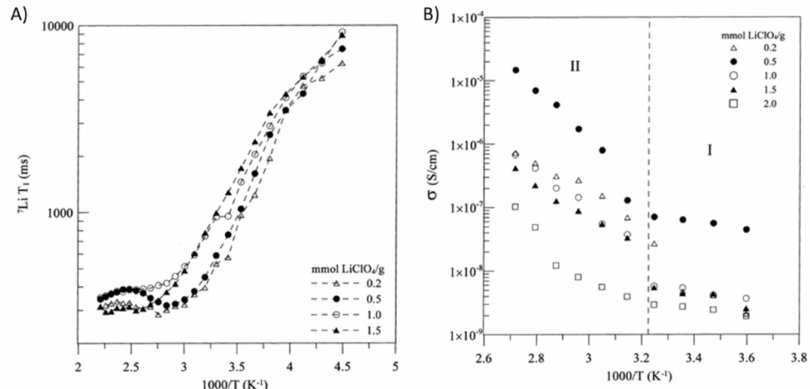
Figure 8. ( A ) Variable temperature T 1 relaxation times for a series of LiClO 4 -doped polyurethane- poly(dimethylsiloxane) copolymers with various salt concentrations. ( B ) Ionic conductivity as a func- tion of temperature for a series of LiClO 4 -doped polyurethane-poly(dimethylsiloxane) copolymers with various salt concentrations. Reprinted with permission from [76]. Copyright 2002 American Chemical